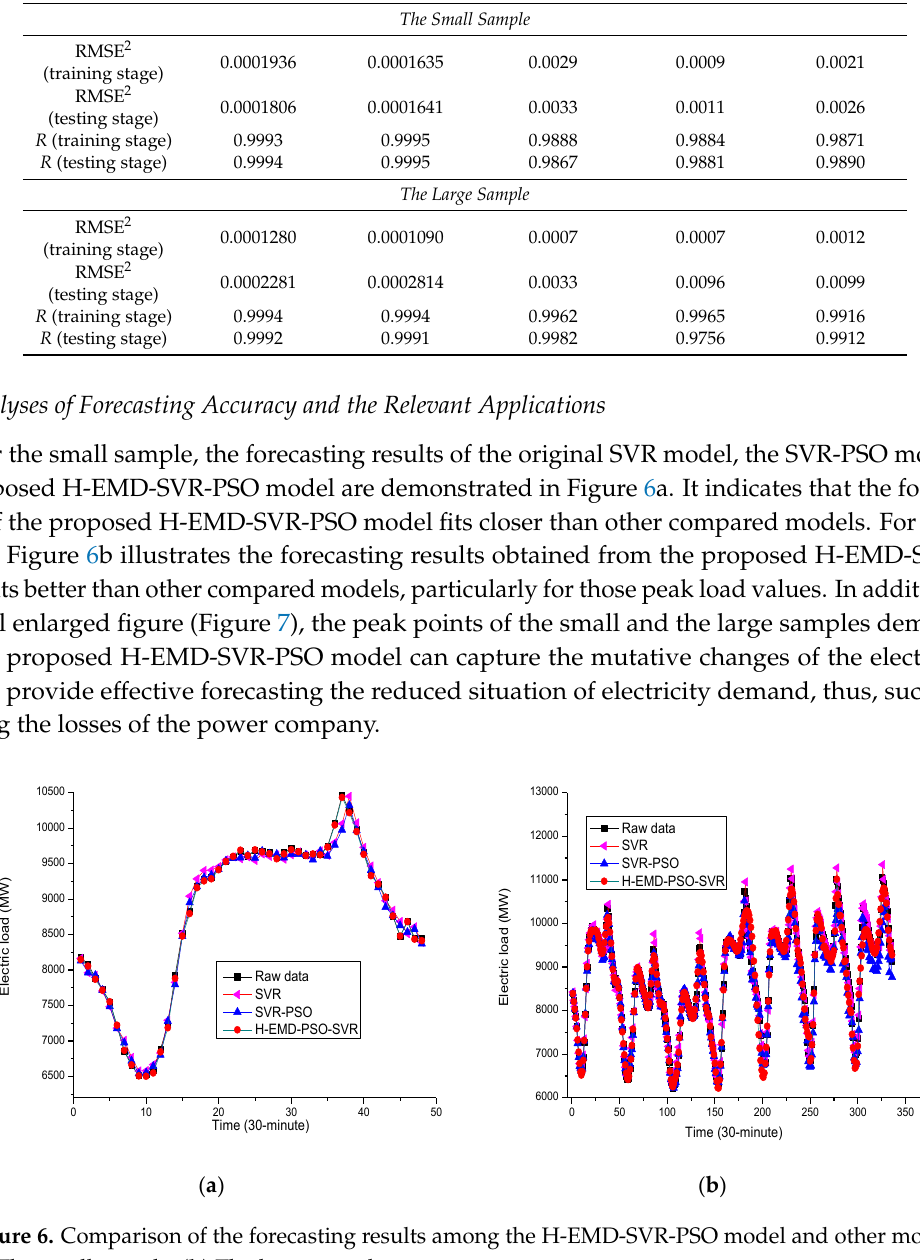
Table 2. Summary of the forecasting results for each defined items.